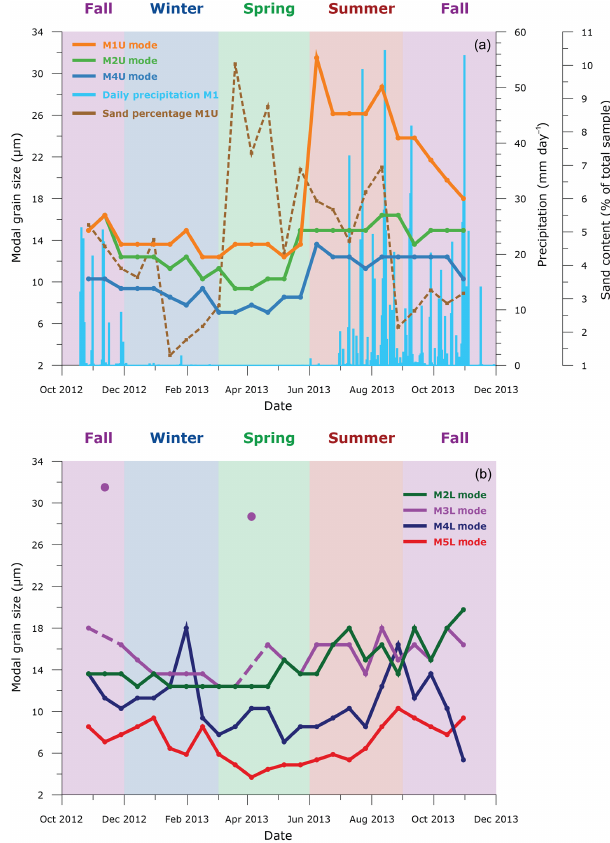
Figure 7. (a) Modal particle diameter of dust collected by the three upper (1200m) sediment traps at stations M1, M2, and M4 (left axis), daily precipitation (right axis; TRMM) and percentage of sand particles (>63µm) (far right axis) at station M1. (b) Modal particle diameter of dust collected by the three lower (3500m) sed- iment traps at station M2, M3, M4, and M5. The two points that are not connected in series M3L are considered